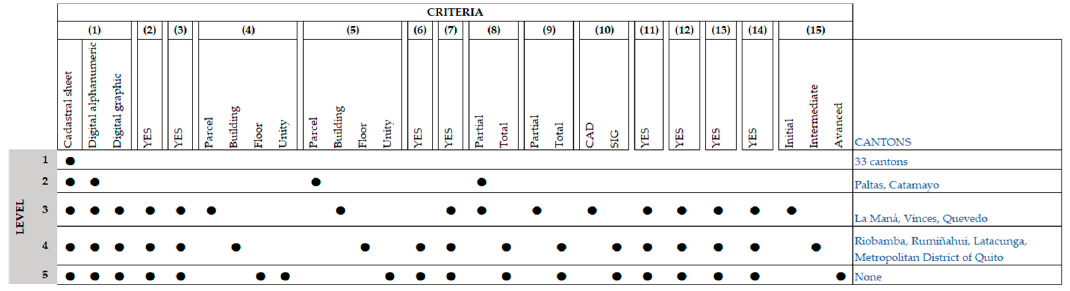
Figure 2. Levels of cadastral development and criteria considered for their definition.